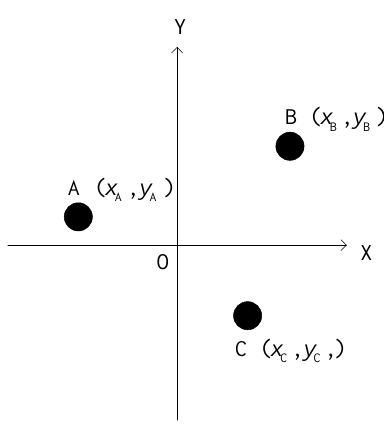
Figure 5. The position of antenna